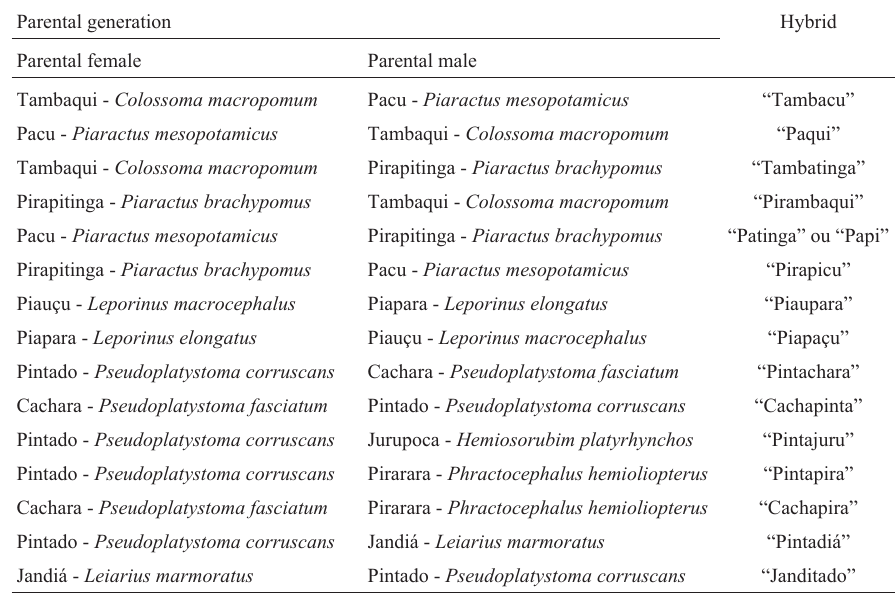
Table 1 - A list of fish species and crosses that produce hybrids identified through the parental